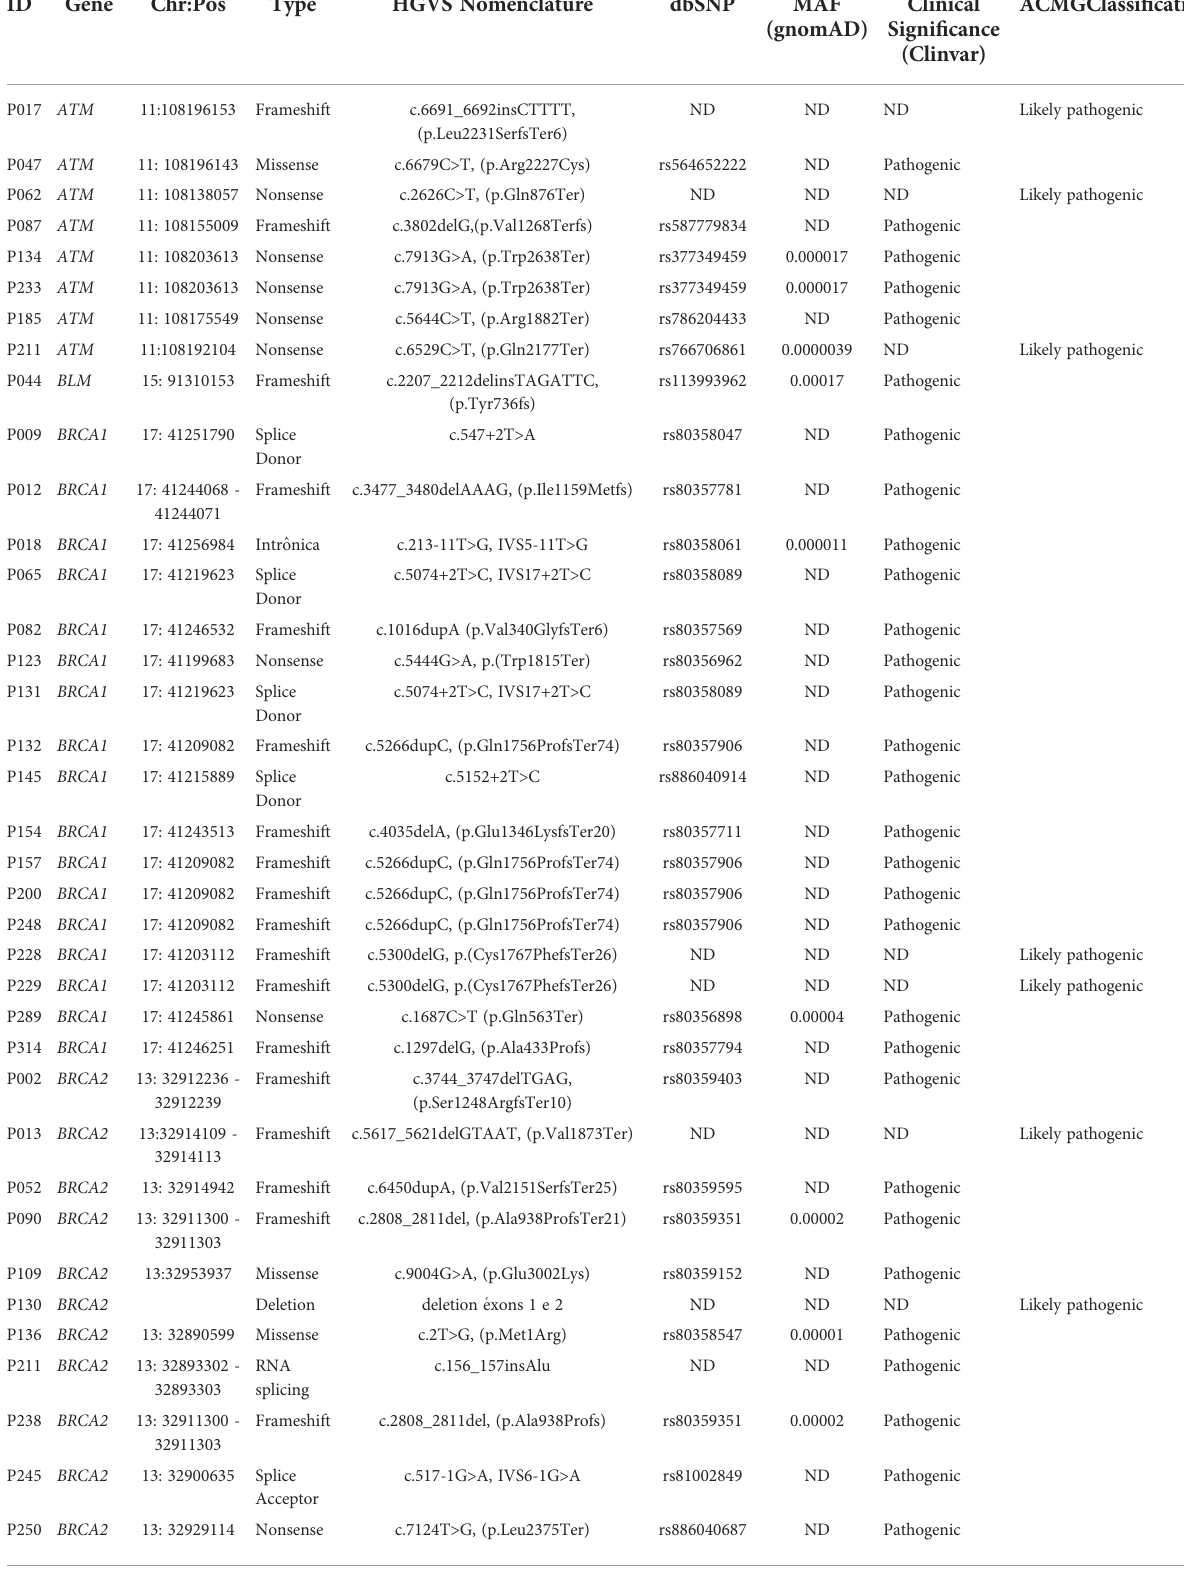
TABLE 3 Description of the identi fi ed 83 germline pathogenic